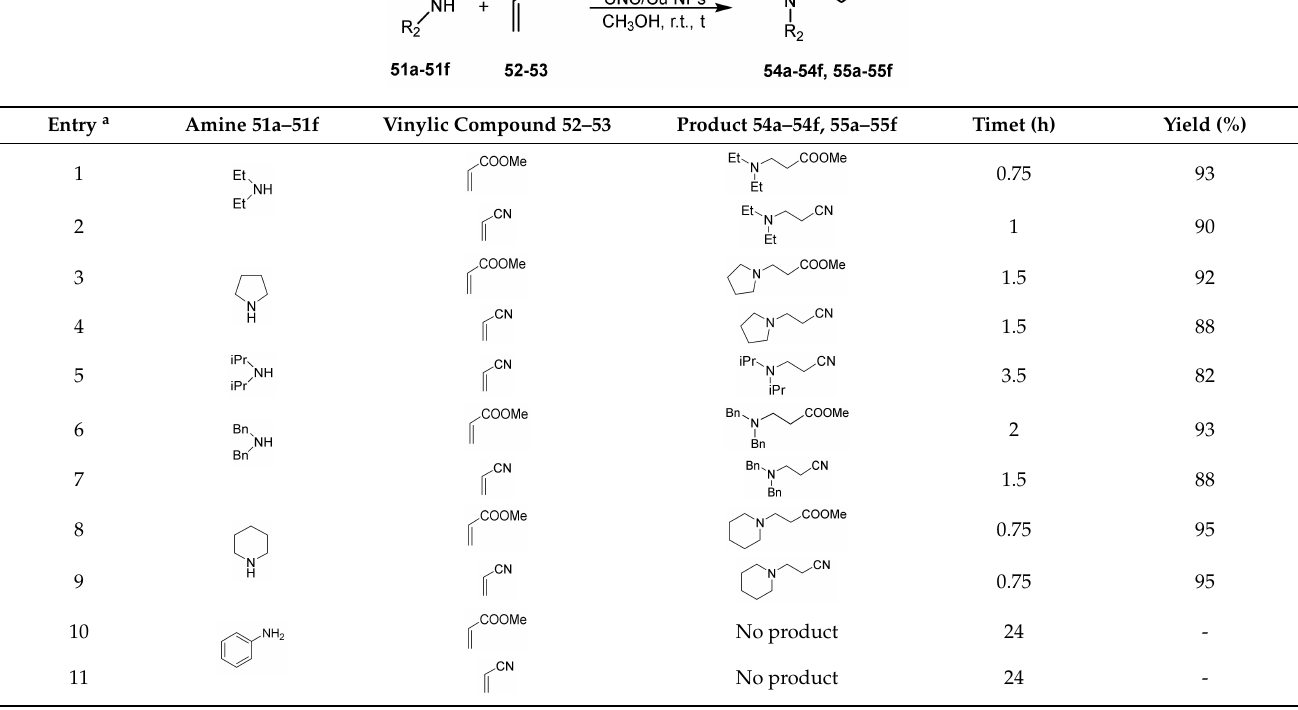
Table 5. aza -Michael reaction between different amines and electron deficient vinylic